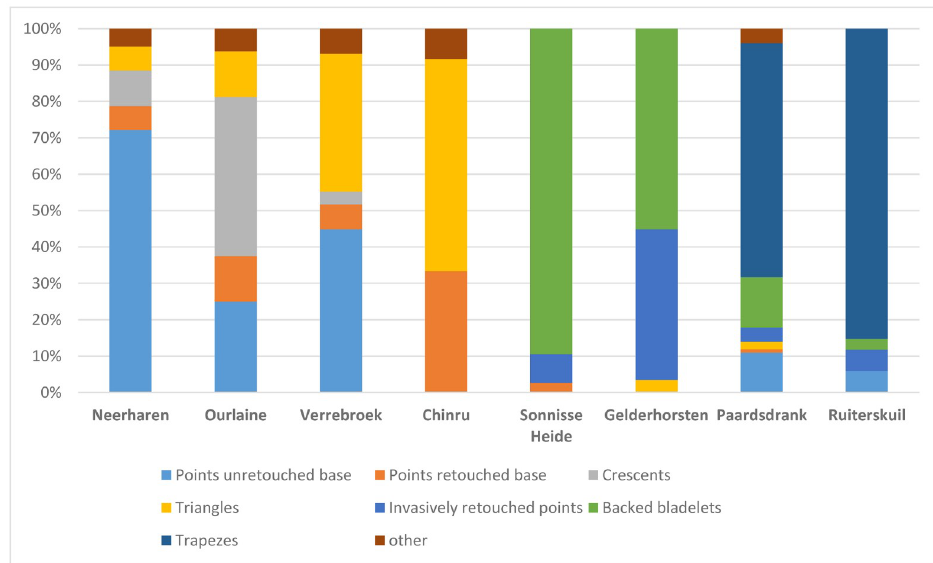
Fig 2. Microlith composition of the eight ATs defined within the Rhine-Meuse-Scheldt region.